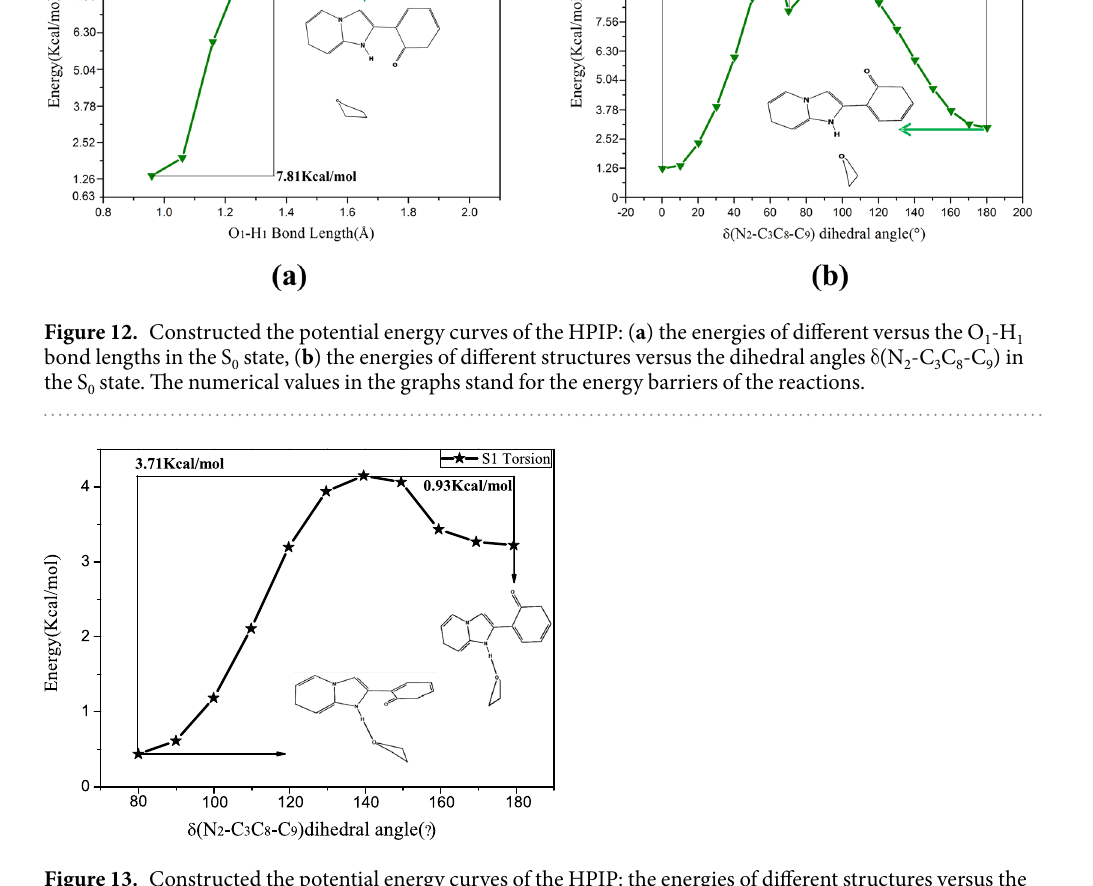
Figure 13. Constructed the potential energy curves of the HPIP: the energies of different structures versus the dihedral angles δ (N 2 -C 3 C 8 -C 9 ) in the S 1 state. The numerical values in the graphs stand for the energy barriers of the